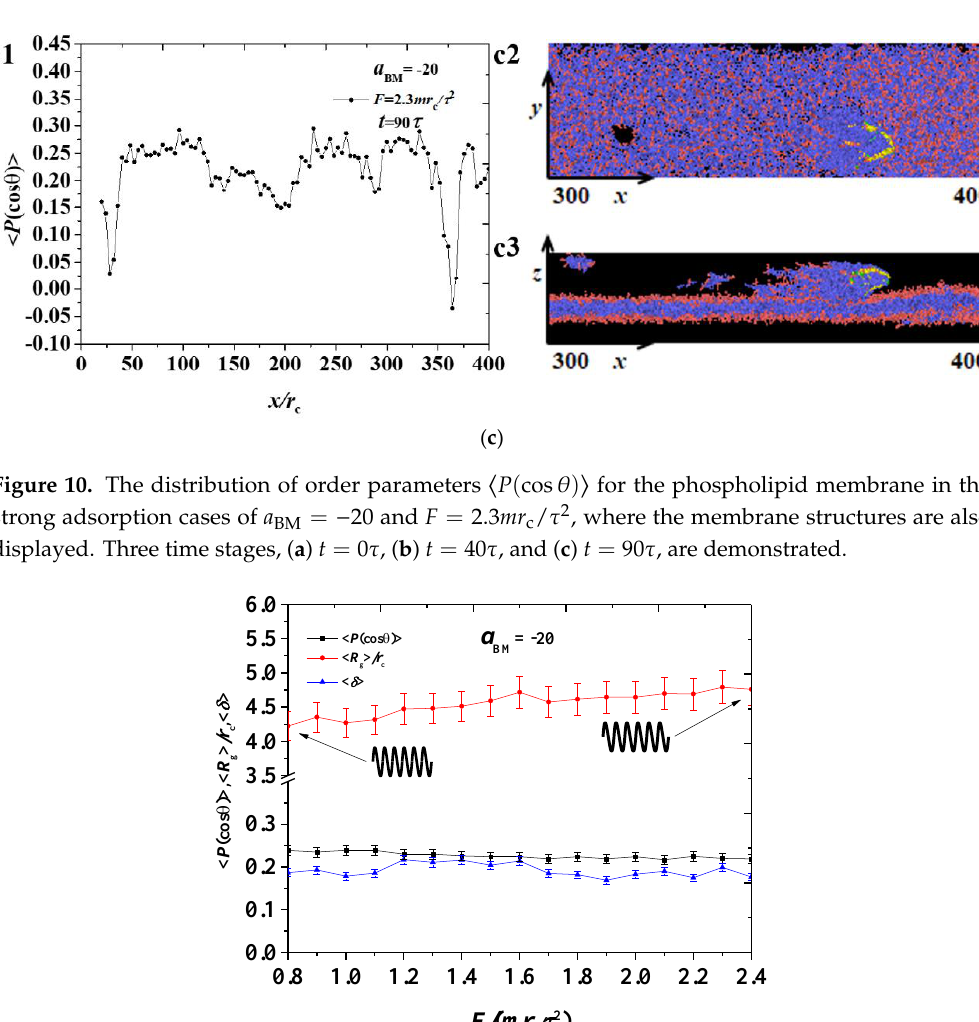
(cid:68) (cid:69) R and average shape R g and average shape g R and average shape g